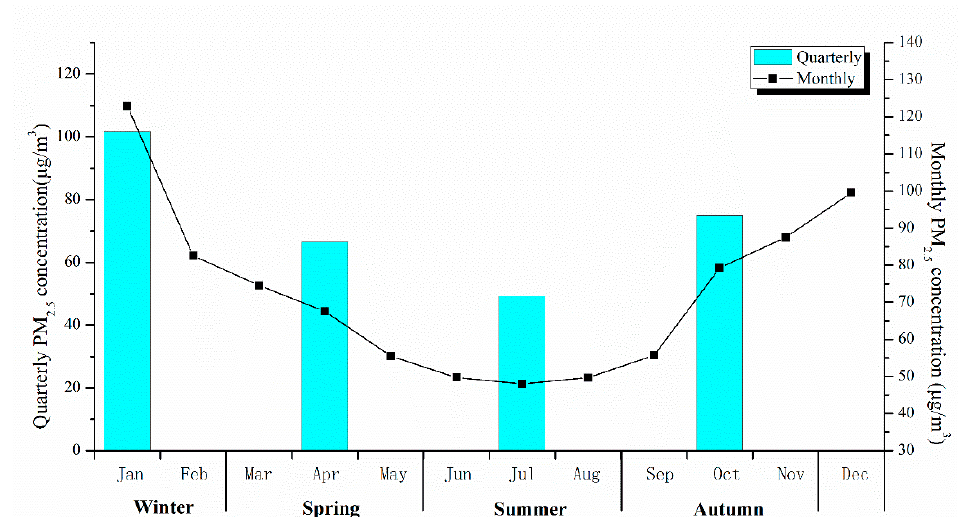
Figure 3. Quarterly and monthly characteristics of PM 2.5 concentration in Weifang.